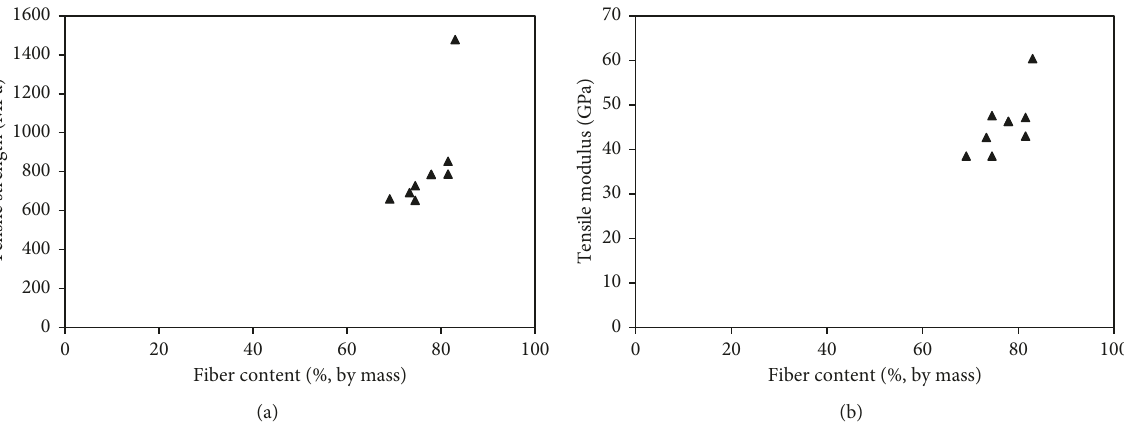
Figure 5: Correlation between fiber content and mechanical properties. (a) Tensile strength. (b) Tensile modulus. Table 5: Summary of conditioning regimes in studies investigating the microstructure of GFRP reinforcing bars.